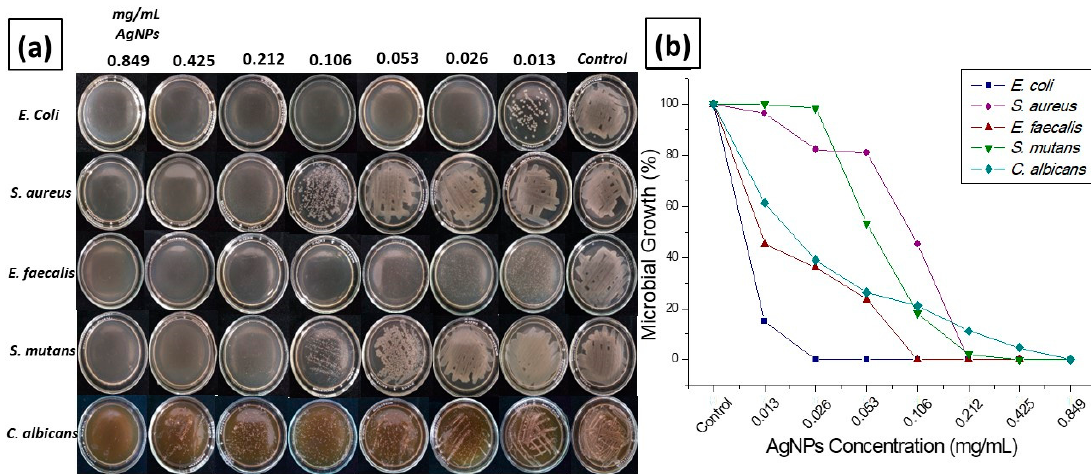
Figure 4. Antimicrobial activity against: ( A ) Streptococcus mutans , ( B ) Staphylococcus aureus , ( C ) Esch- erichia coli , ( D ) Enterococcus faecalis , ( E ) Candida albicans . Disk 1, 24 h after synthesis; disk 2, 7 days after synthesis; disk 3, 14 days after synthesis; disk 4, 21 days after synthesis; disk 5, control disk only with clove extract.